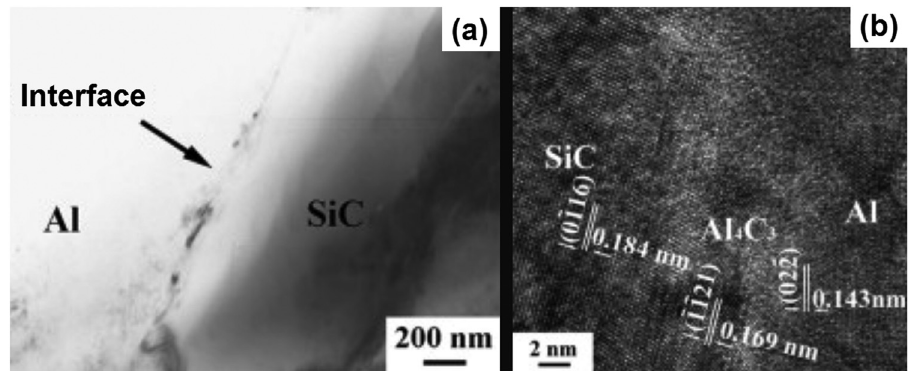
Figure 3: TEM ( a ) and HRTEM ( b ) images of the interface SiC/Al with the presence of the Al 4 C 3 interlayer for a 2009 Al alloy reinforced with 15% SiC particles ( Reproduced with permission from [ 86 ] . )